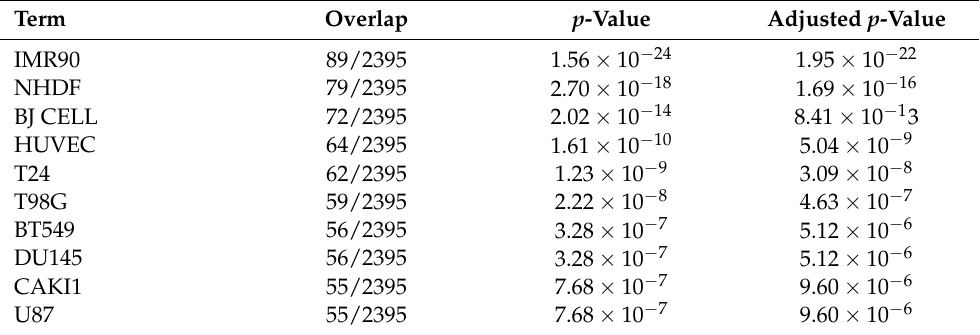
Table 5. The top 10 enriched terms in “ARCHS4 Cell-lines” using Enrichr. Overlap is the number of common genes between the genes uploaded and the genes in the category divided by the number of genes in the category. Probes, whose associated genes were uploaded to Enrichr, were identified using PCA-based unsupervised FE.